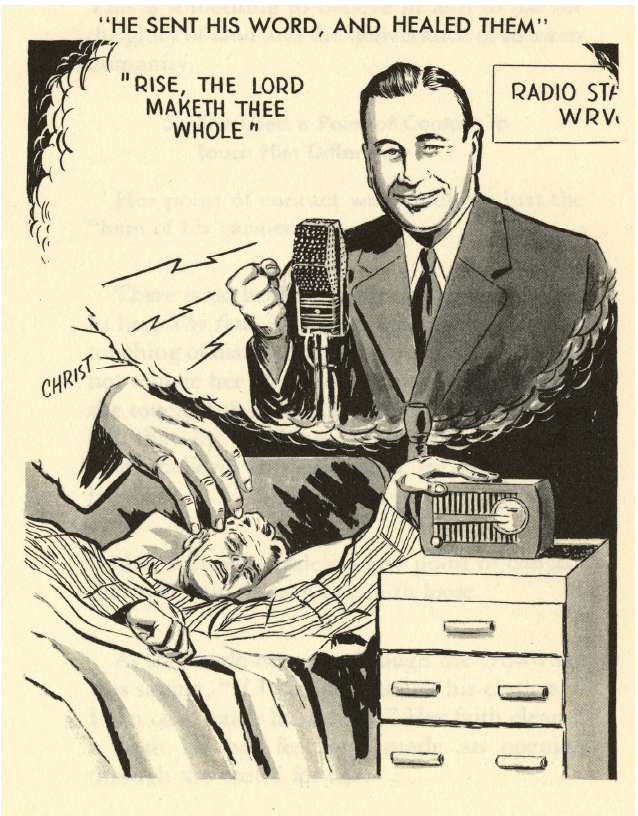
Figure 2. Cartoon illustration from If You Need Healing Do These Things.